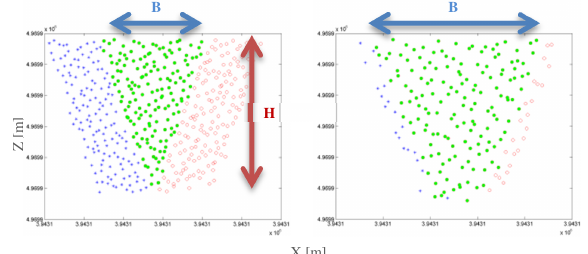
Figure 9. On the left side: 60% of overlap and 150 TP, on the right side: 90% of overlap and 150